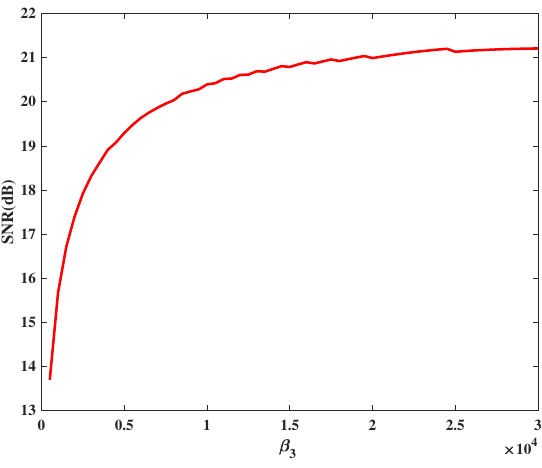
Figure 4. The SNR for results with different β 3